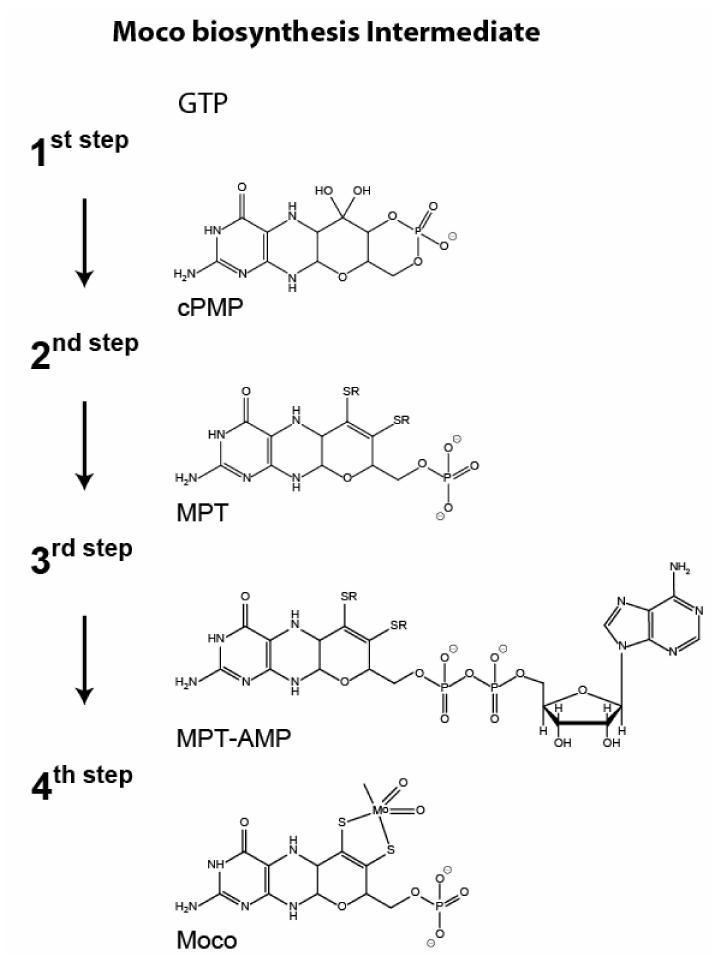
Figure 1. Scheme of the molybdenum cofactor biosynthesis pathway. Biosynthesis of the molybdenum cofactor(Moco)involvesthestepwiseconversionofguanosinetriphosphate(GTP)tocyclicpyranopterin monophosphate (cPMP [8,9,16], step 1) which is converted to molybdopterin (MPT, [10–12]) in